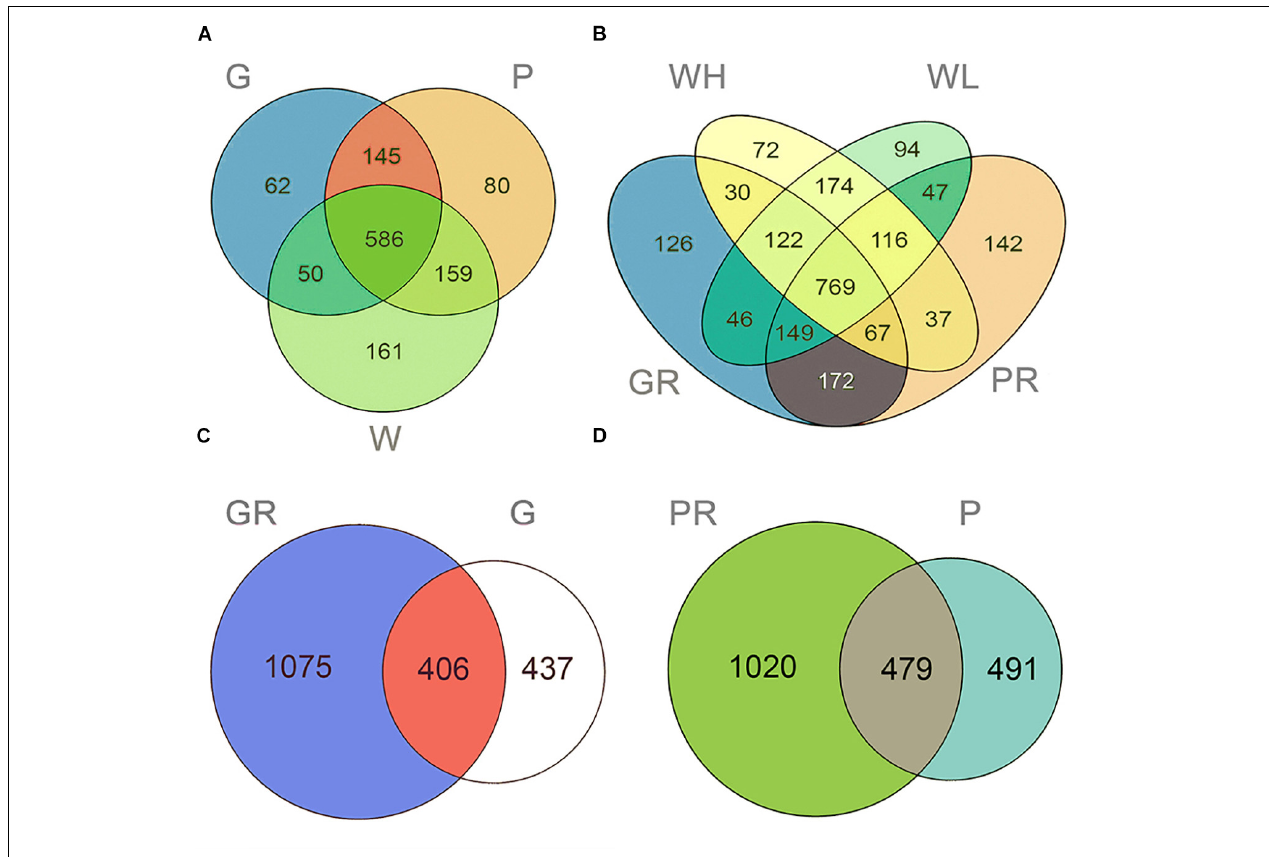
FIGURE 2 | Venn diagrams displaying the number of unique and shared OTUs in different samples of Ming Lake (A) and Pearl River (B) and the number of unique and shared OTUs in different environment of glass slides (C) and PFUs (D) . Samples are named as follows: G, glass slides in Ming Lake; P, PFUs in Ming Lake; W, water columns in Ming Lake; GR, glass slides in Pearl River; PR, PFUs in Pearl River; WH, water columns at high tide in Pearl River; WL, water columns at low tide in Pearl River. Detailed information of samples is given in Supplementary Table S1 .